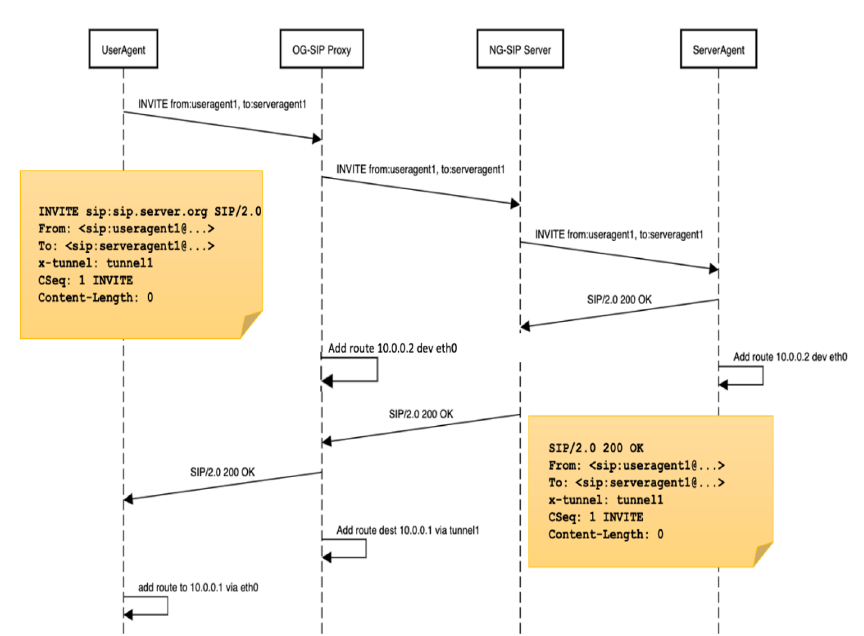
Figure 7. SIP INVITE method used to create virtual circuit in ACS.